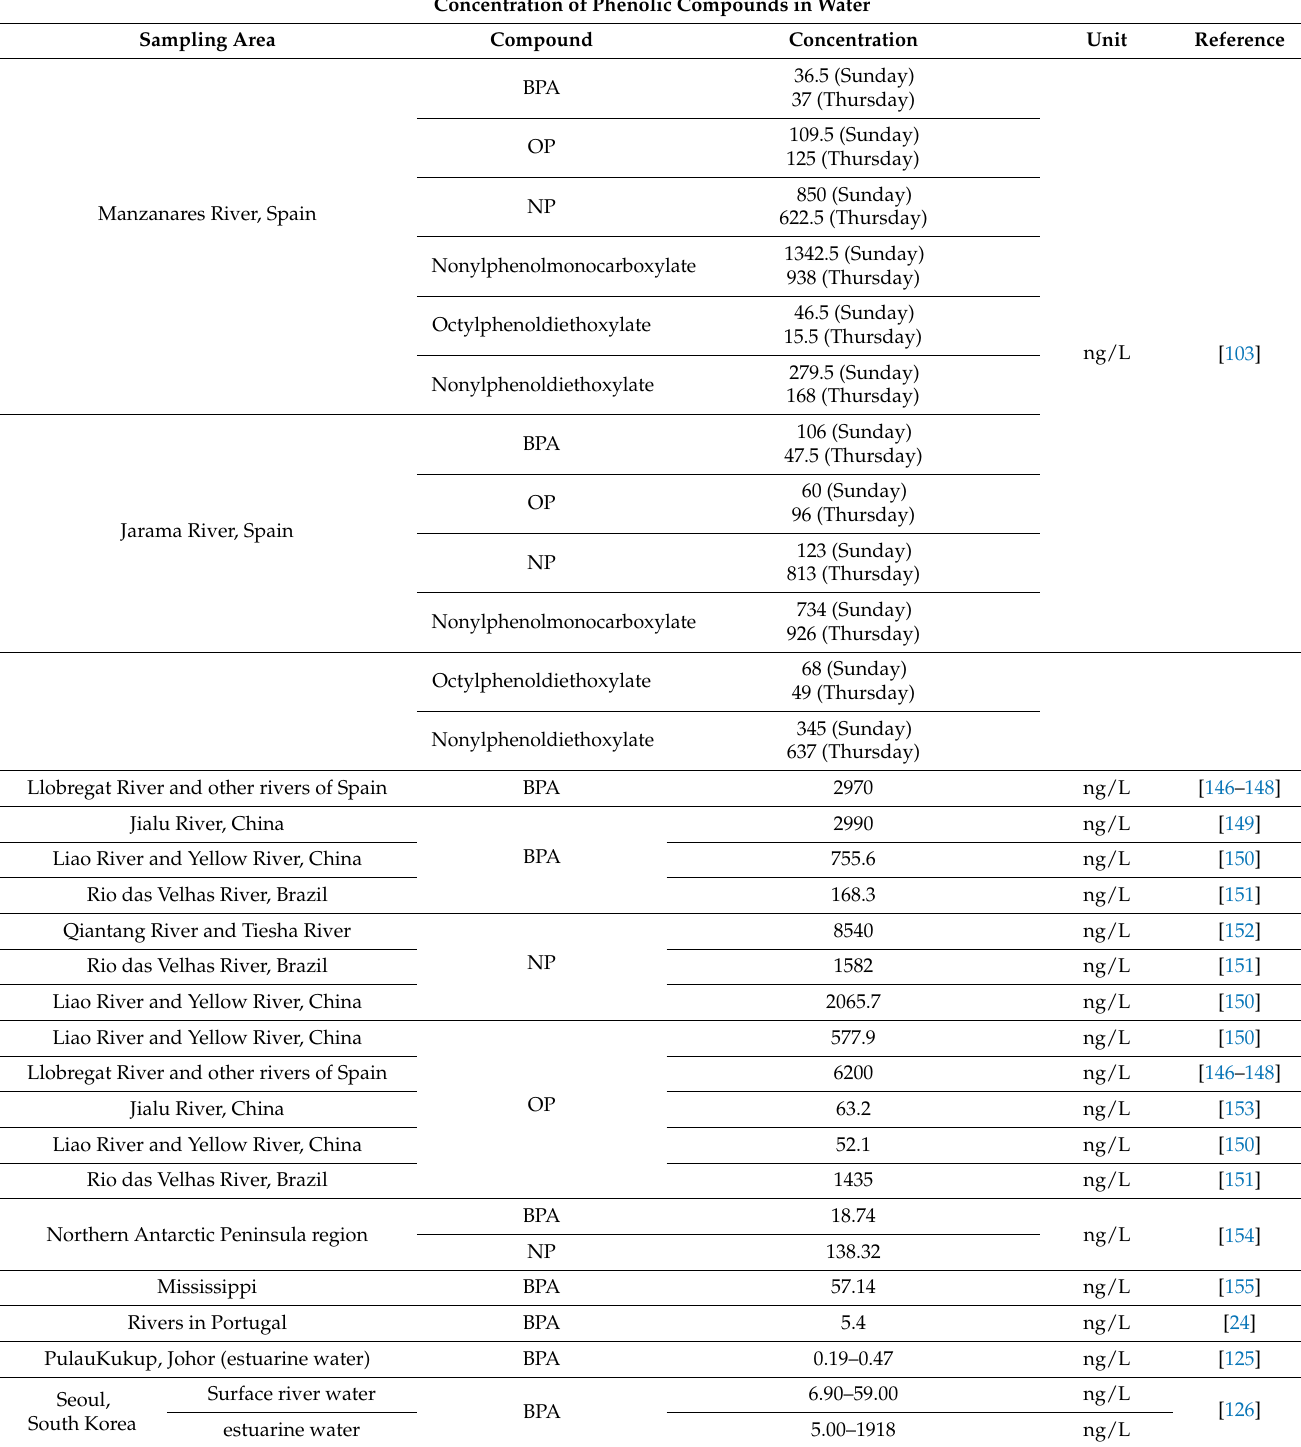
Table 2. Phenolic compounds in environmental matrices and human